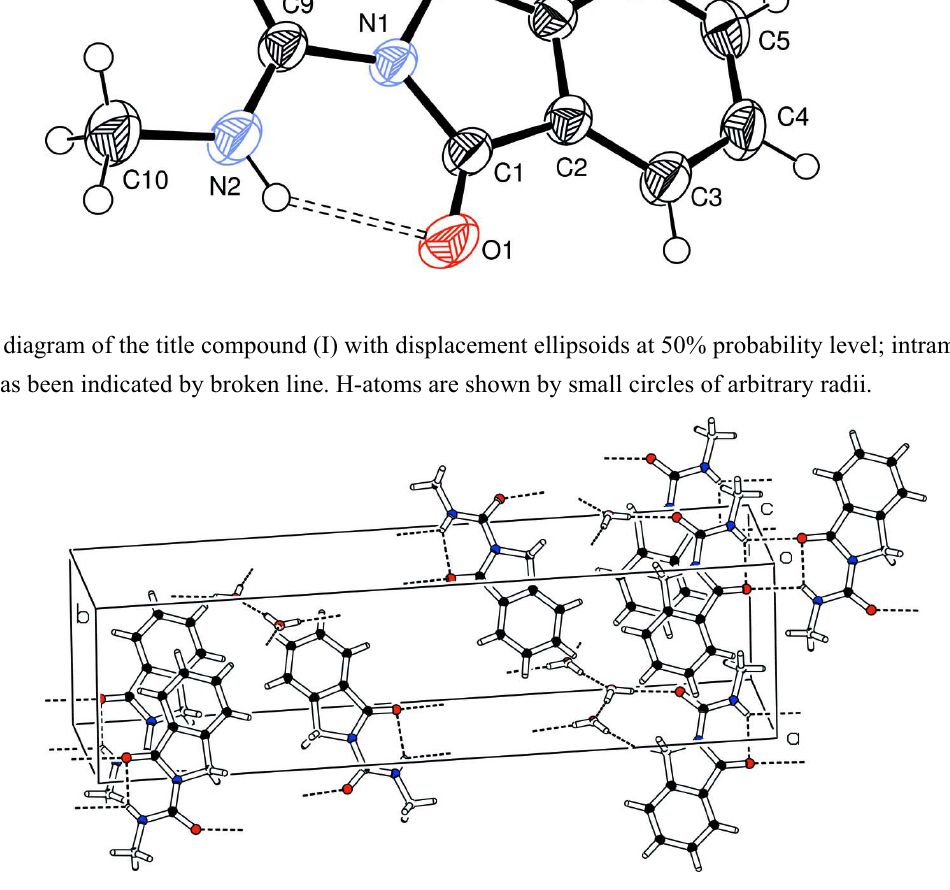
The packing figure ( PLATON : Spek, 2003) which shows the H-bonding and the overlapping of rings which generate π - π